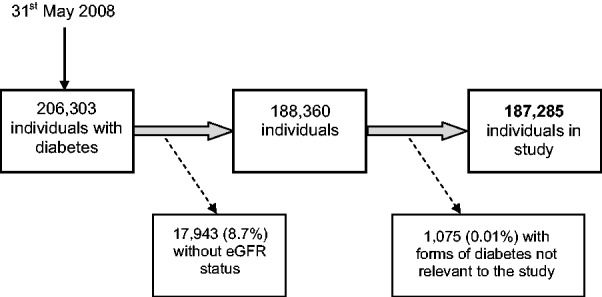
Identification of records included in study.